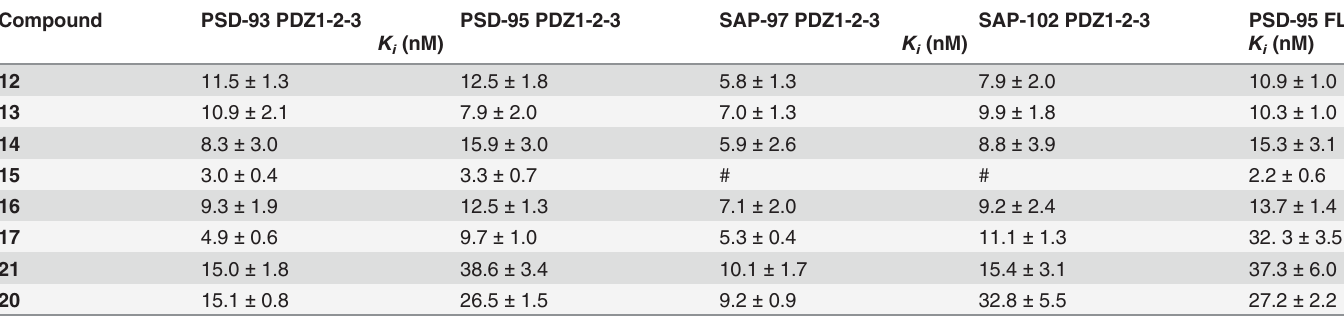
Table 1. Af fi nity of trimeric ligands (12 – 17 and 21) and dimeric ligand 20 toward the PDZ1-2-3 tandems of PSD-93, PSD-95, SAP-97 and SAP-102 and FL PSD-95 as determined by FP a .